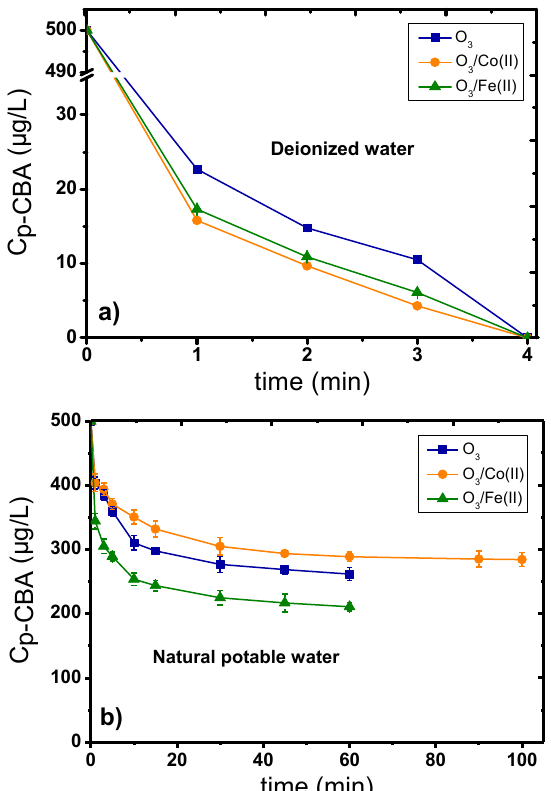
Figure 1. Catalytic ozonation of p-CBA with the use of Fe(II) and Co(II) as catalysts in ( a ) deionized water, and ( b ) dechlorinated natural potable water. Experimental conditions: initial p-CBA concentration 500 μ g/L, ozone concentration 2 mg/L, catalyst concentration 1 mg/L, pH 7.8, temperature 23 ± 2 °C.